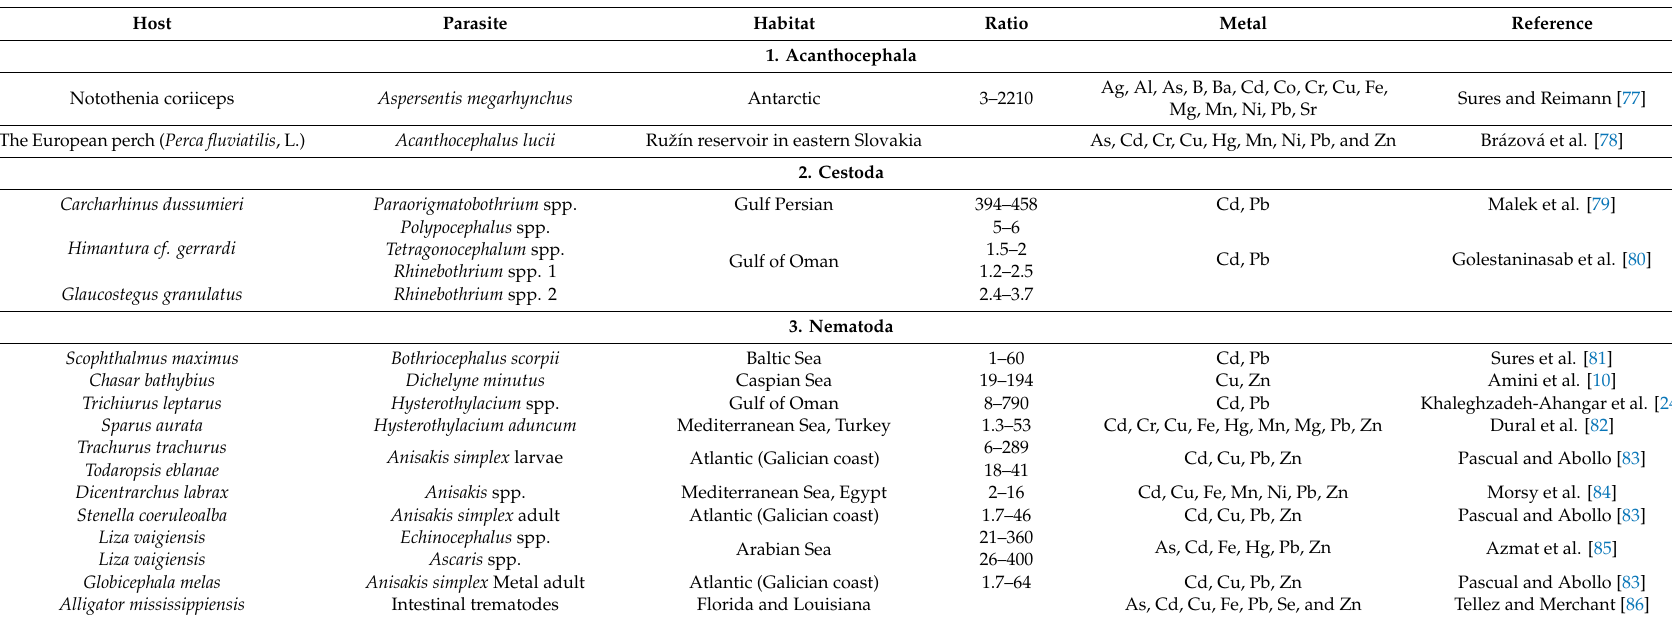
Table 2. A summary of the main findings of metal accumulation studies in di ff erent marine species. Metals were accumulated in the parasite in high ration compared to host muscle